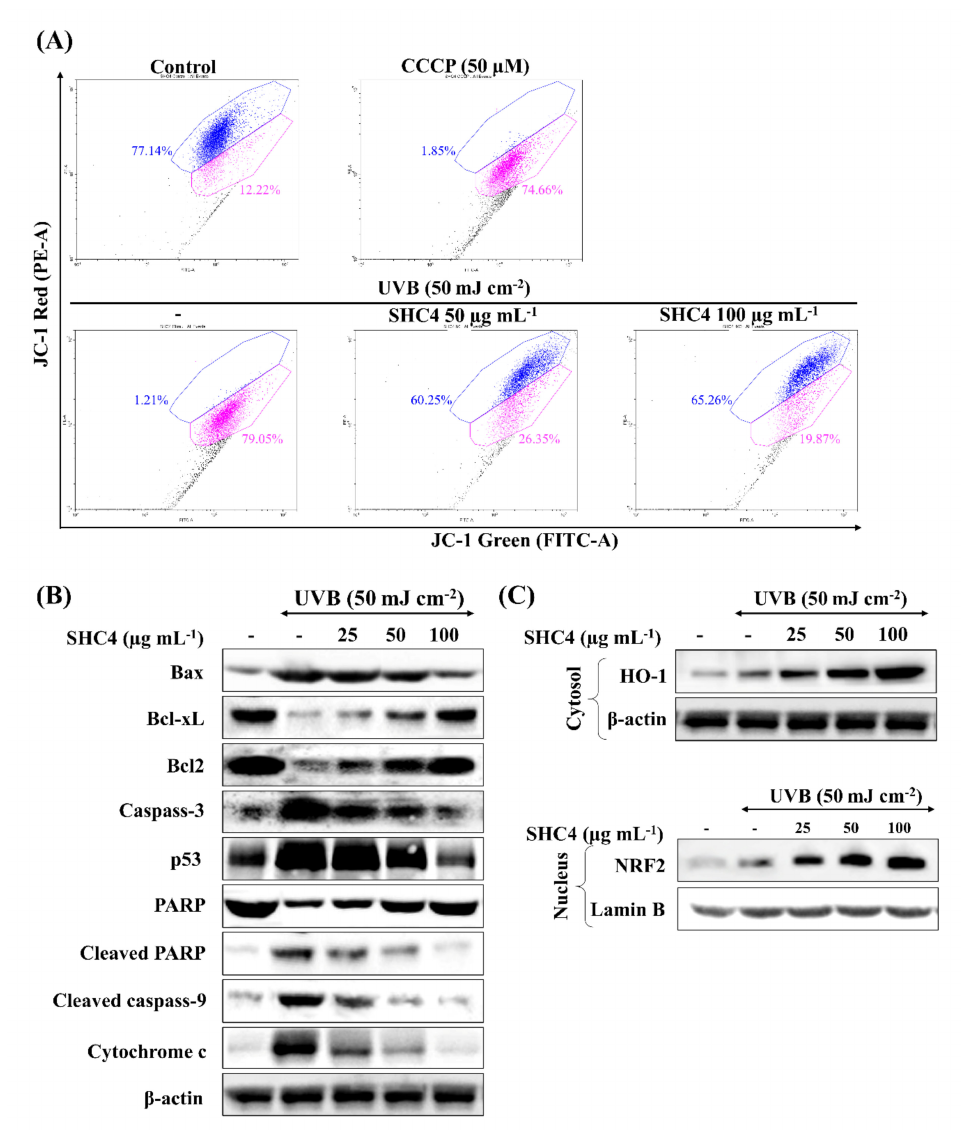
Figure 6. Western blot analysis of the protective e ff ects of SHC4 against UVB-induced apoptosis